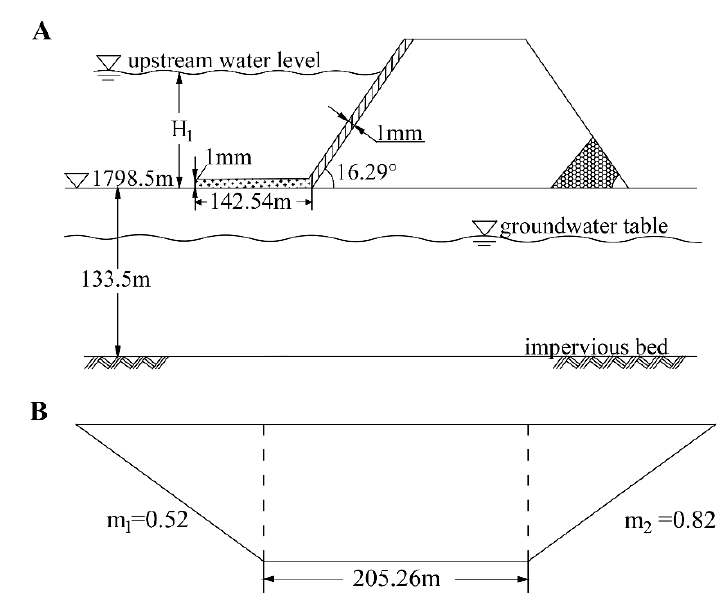
Figure 6. Simplified calculation diagrams: ( A ) a typical cross section of the embankment dam; ( B ) front view of the simplified slope wall.